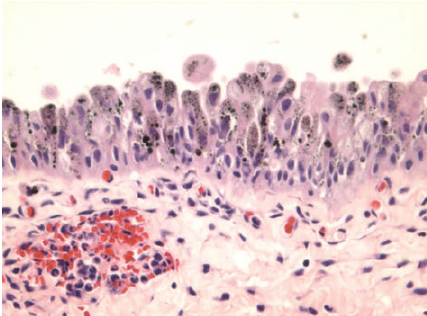
Figure 3: Bladder metastatic melanoma. Haematoxylin and Eosin stain: primary melanoma of the urinary bladder is very rare. In comparison, between 15% and 20% of patients who are dying of melanoma have urinary bladder involvement. This figure represents metastasis to the urinary bladder in a patient with known history of malignant melanoma, taken from Bladder Melanoma Pathology http://outlines.com/ with permission to reproduce the figure from